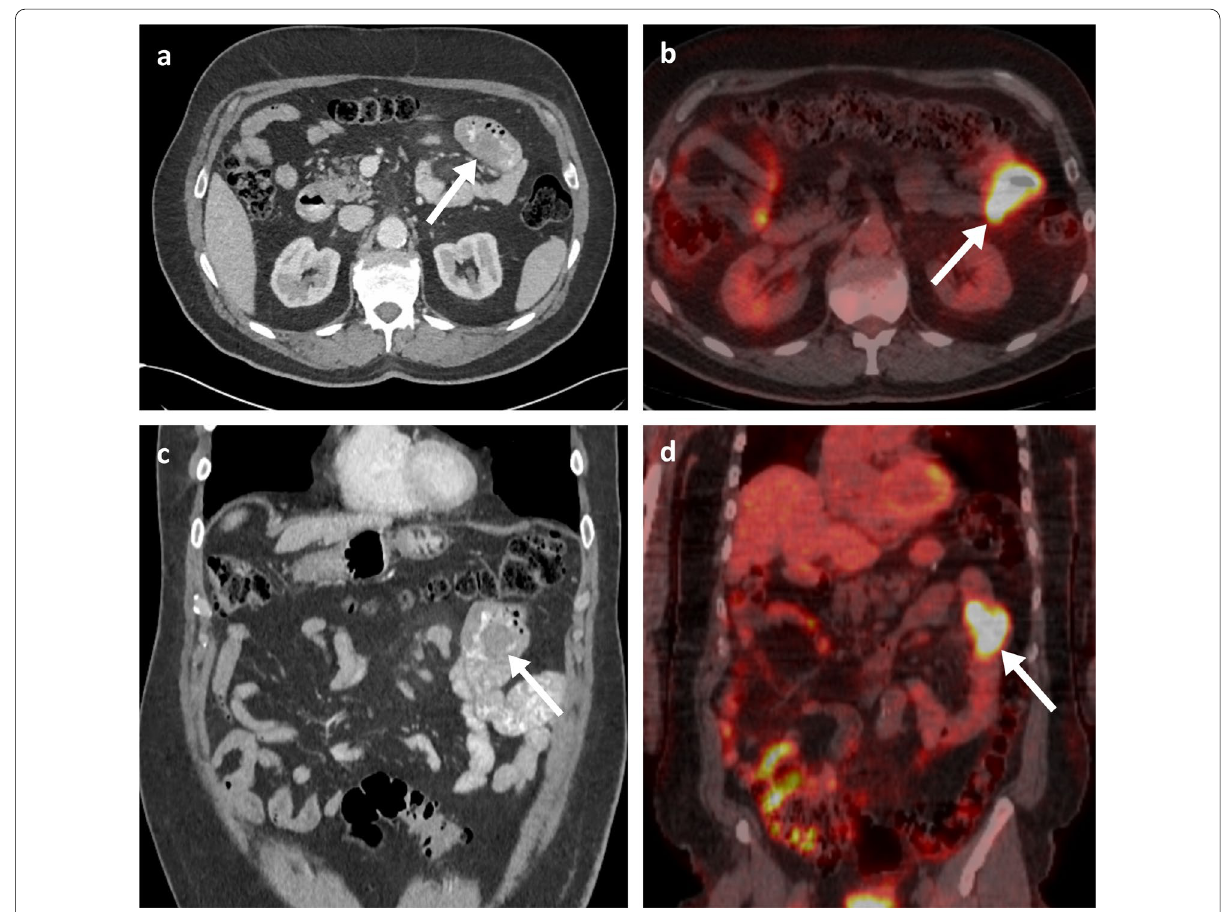
Fig. 5 Oral and intravenous portal phase contrast-enhanced CT axial ( a ) and coronal ( c ) of a 70-year-old male patient with an eccentric mural melanoma metastasis within the proximal jejunum (arrows). PET-CT axial ( b ) and coronal ( d ) demonstrating FDG avidity with an SUVmax of 21.7 (arrows)